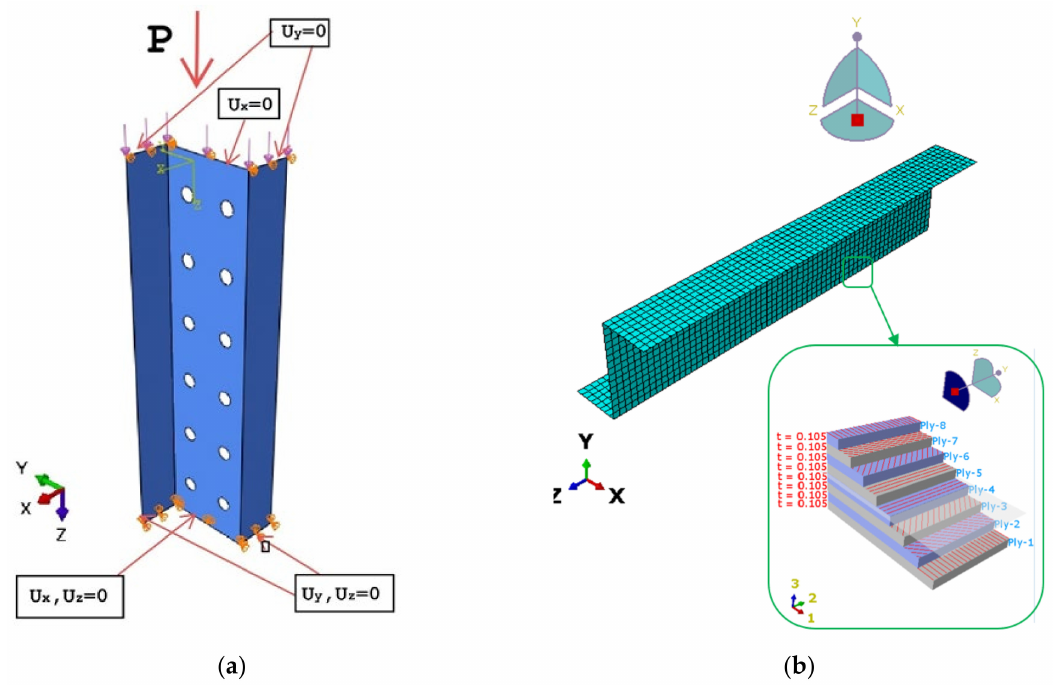
Figure 5. ( a ) Boundary conditions, ( b ) discrete model.